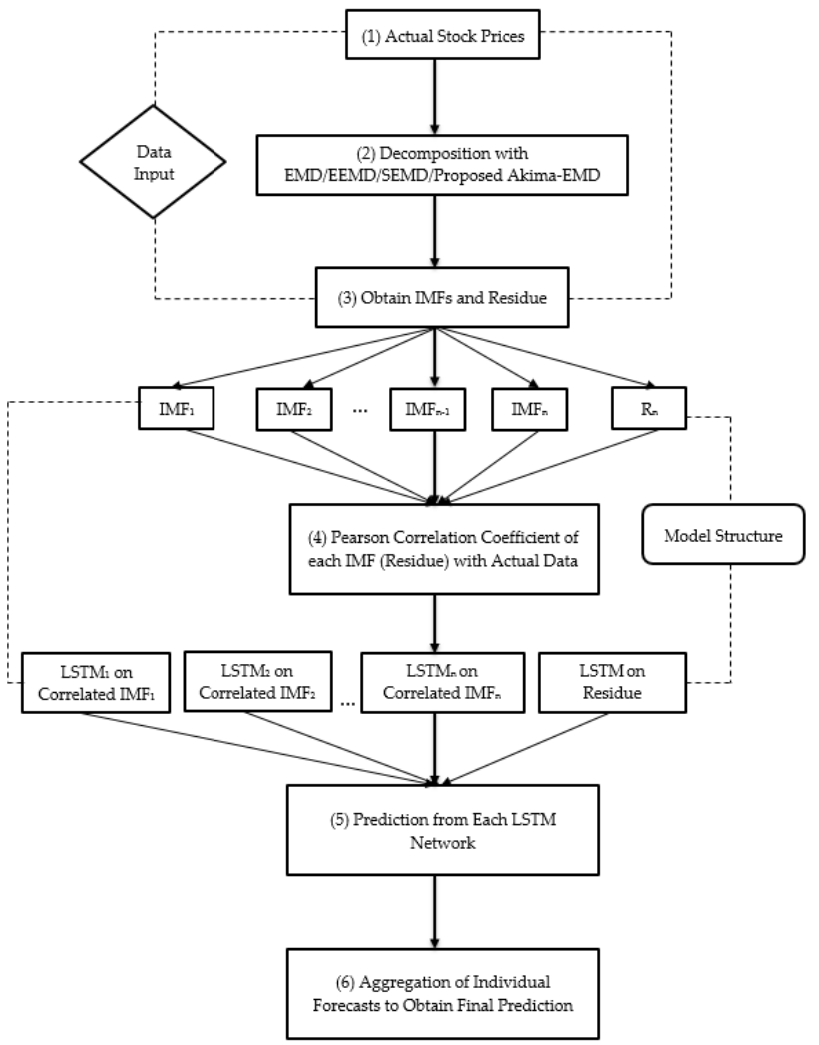
Figure 3. Flowchart of our improved hybrid model.